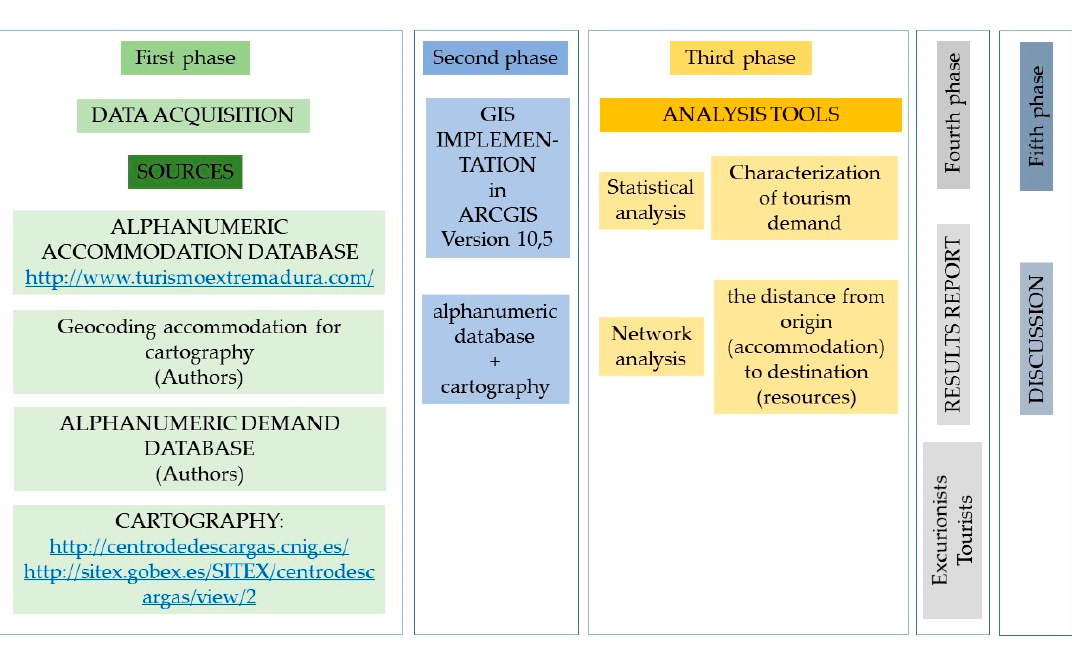
Table 3. Details of the survey carried out of the tourists.